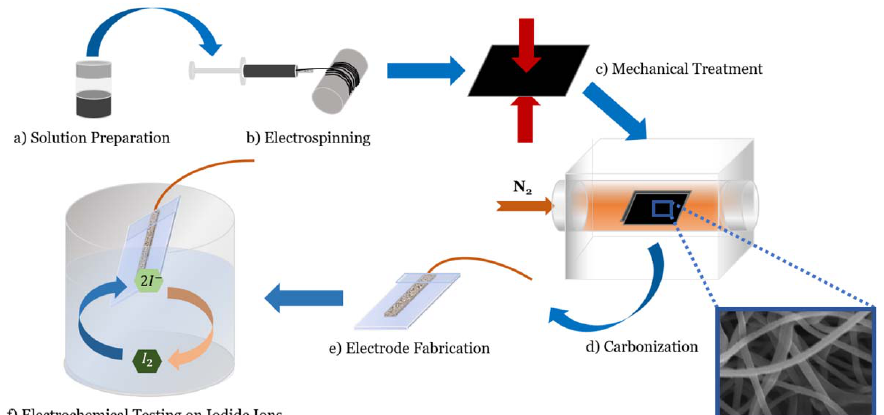
Figure 1. Schematiciagram of the fabrication and electrochemical testing of the MCNF electrodes. ( a , b